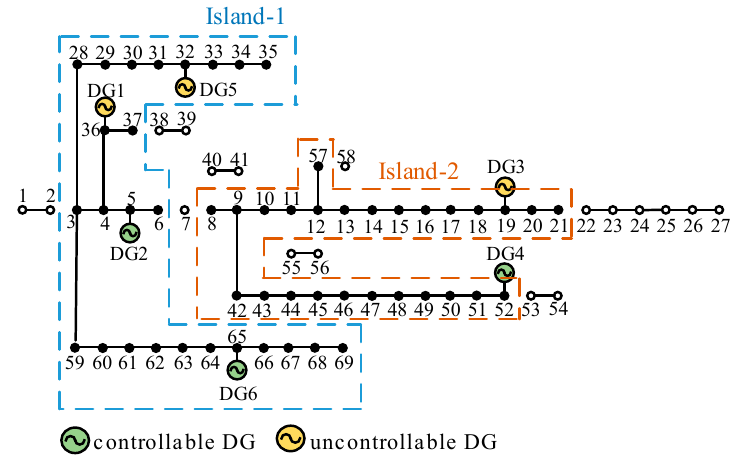
Figure 6. Island partition scheme of the distribution system with multiple distributed generators.